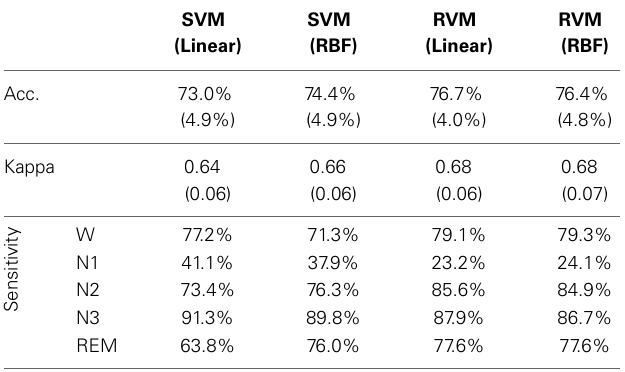
Table 4 | Performance comparison of different kernel functions in SVM and RVM.